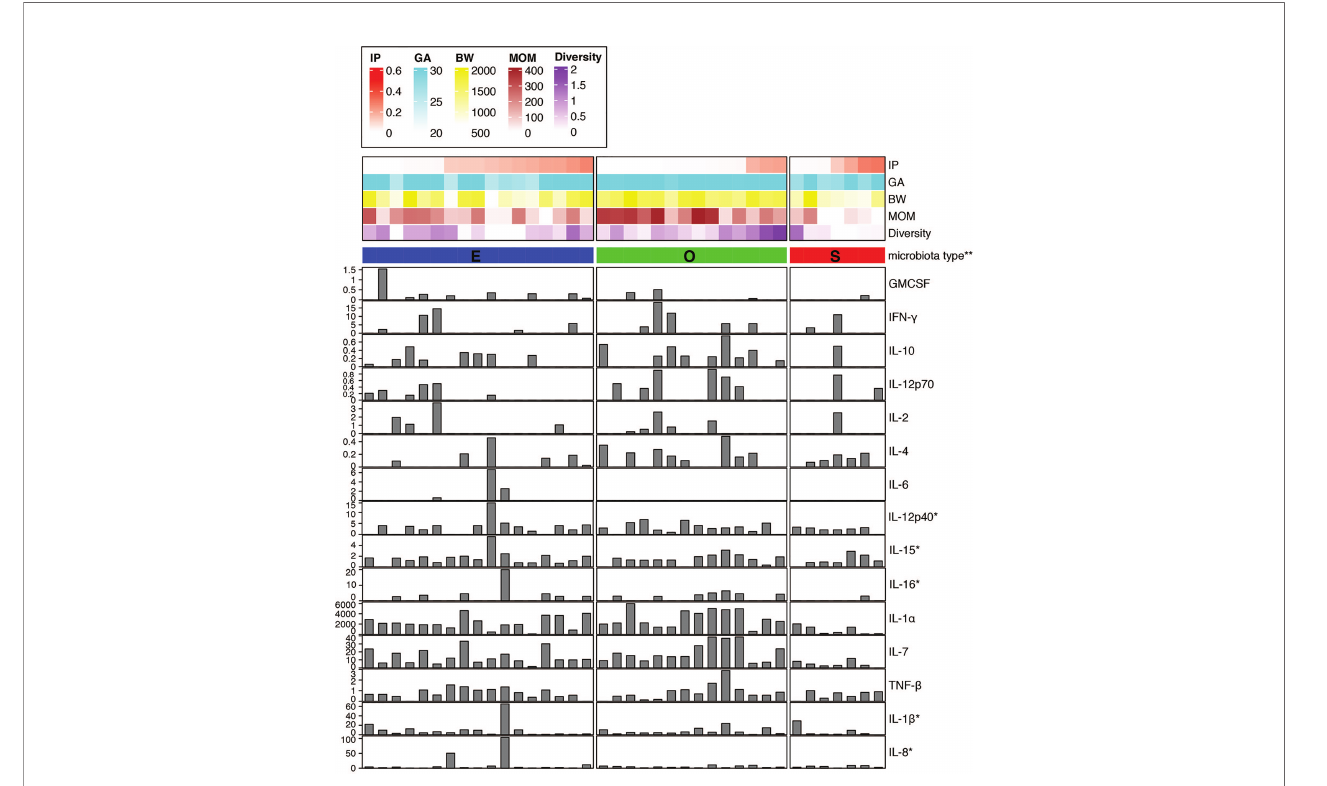
FIGURE 2 | Fecal cytokine pro fi le associated with microbial diversity. Color map of microbial communities correlating with neonatal factors and barplot map of the 15 cytokines detected. Within-sample diversity was estimated using Shannon diversity index using Phyloseq R package (46). Plot was generated using R package ‘ complexheatmap ’ (47). *Value was scaled using square root. **Microbiota type was assigned according to the clustering pattern as shown in Figure 1 . IP, intestinal permeability; GA, gestational age; BW, birth weight; MOM, mother ’ s own breast milk cumulative volume use during the fi rst week prior to IP